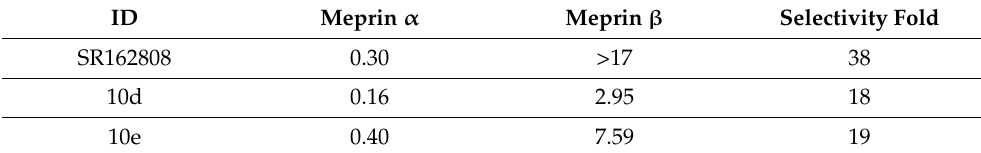
Table 4. Comparison of SR162808 and compounds 10d and 10e from 17 . All units are IC 50 , µ